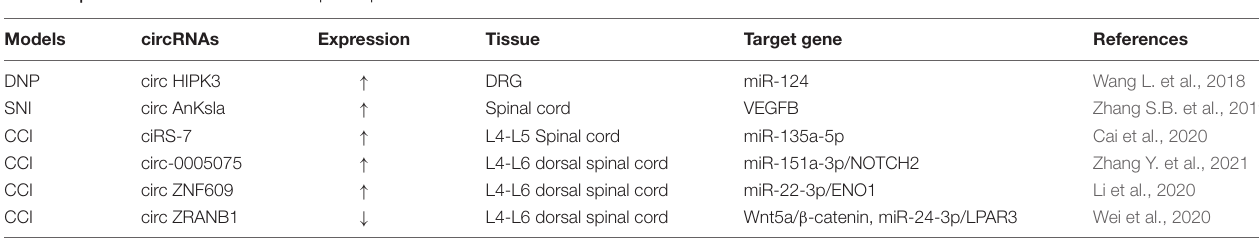
TABLE 3 | CircNAs associated with neuropathic